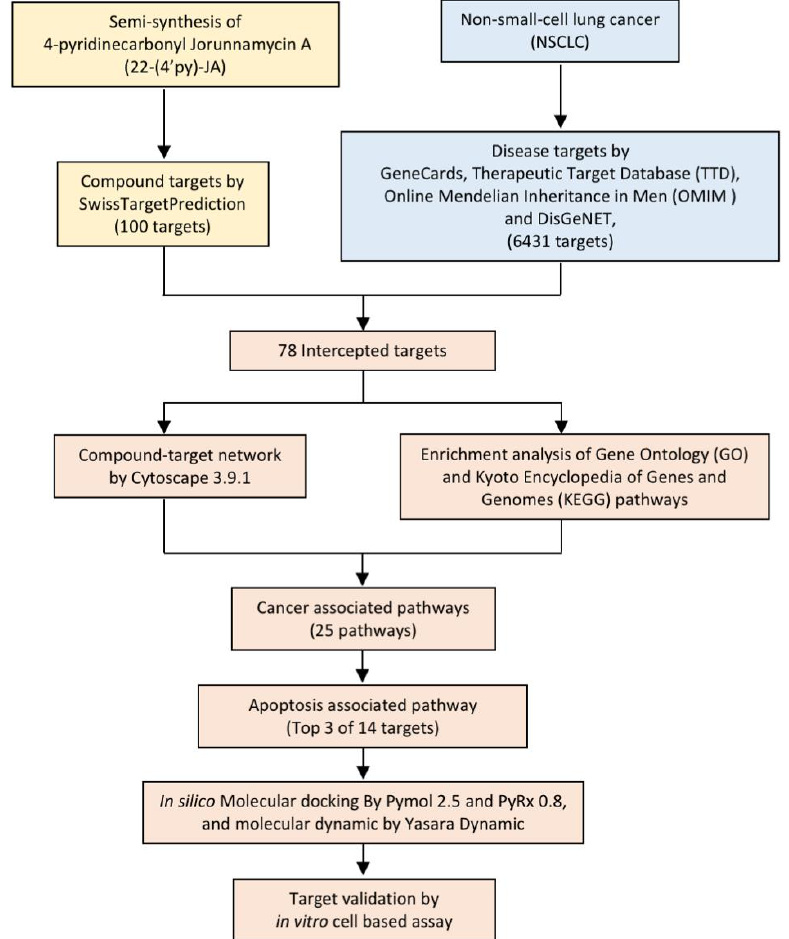
Figure 2. Experimental design.